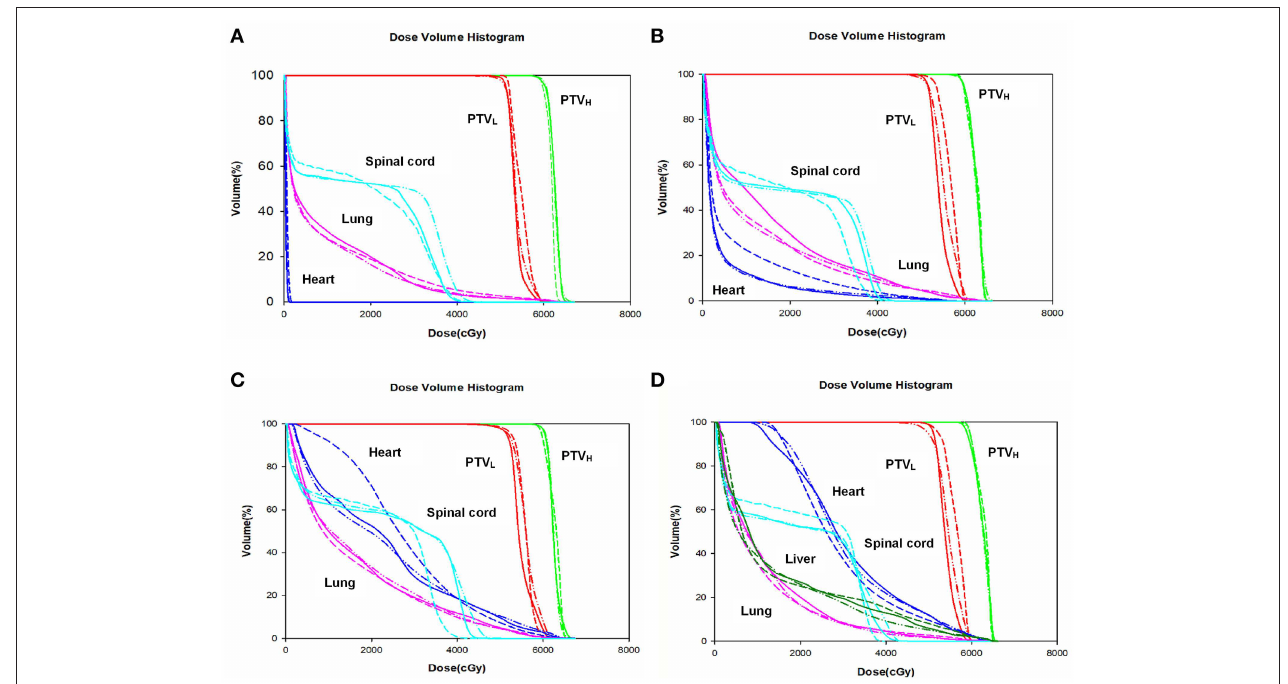
FIGURE 2 | Dose volume histogram. Comparing the dose volume histogram from IMRT, VMAT, and HT of a patient with cervical (A) , upper (B) , middle (C) , and lower (D) thoracic EC. EC, esophageal cancer. Solid line: IMRT; Dashed line: VMAT; Dash-dot-dotted line: HT. IMRT, intensity modulated radiation therapy; VMAT, volumetric modulated radiation therapy; HT, helical tomotherapy. Green: PTV H ; Red: PTV L ; Cyan: spinal cord; Pink: lung; Blue: heart; Dark green: